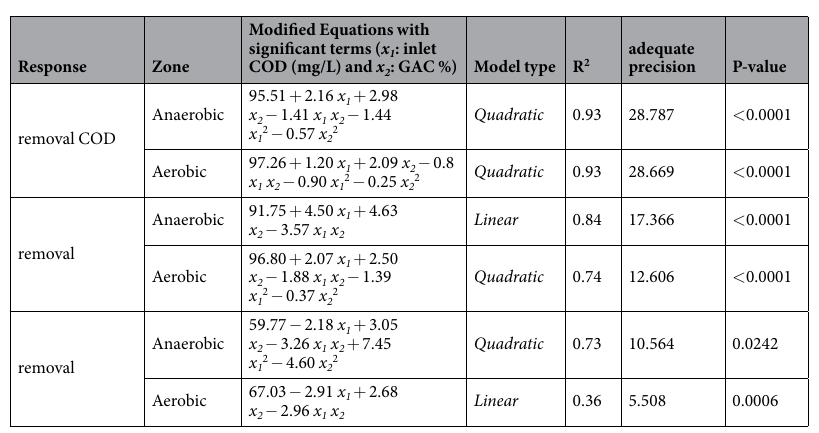
Table 6. Statistical results and derived